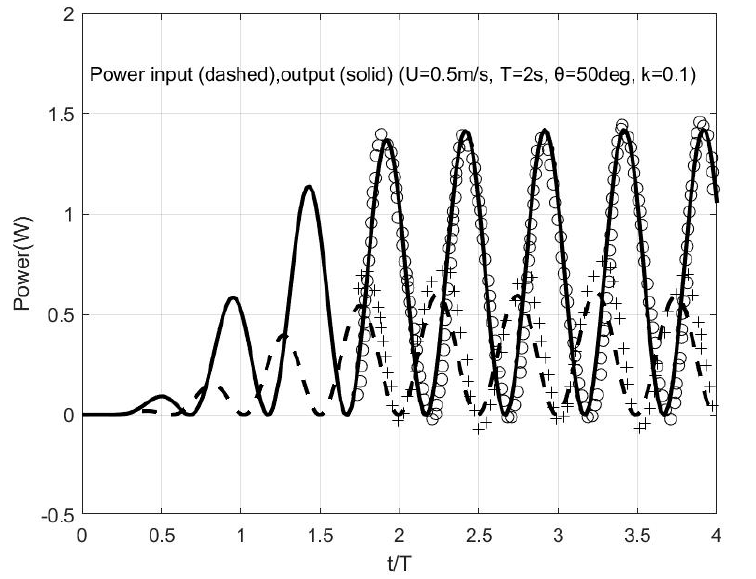
Figure 7. Input and output power as a function time as calculated by the present model for the considered system for the same case as in Figure 4. Input power is shown by using dashed lines and output power by solid lines, respectively. Experimental data from [6] are indicated by using symbols: crosses for input power and circles for output power, respectively.